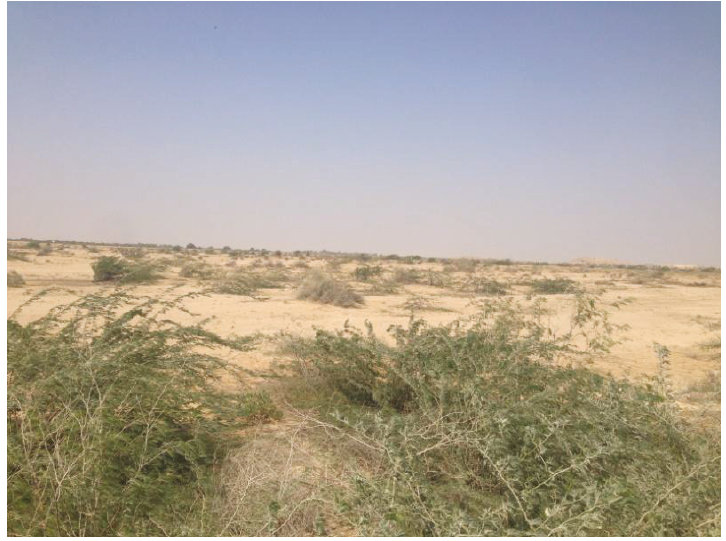
Figure 3: Physical condition of site/land milestone. Table 1: 3 × 50MW project site coordinates. Table 3: Monthly values from